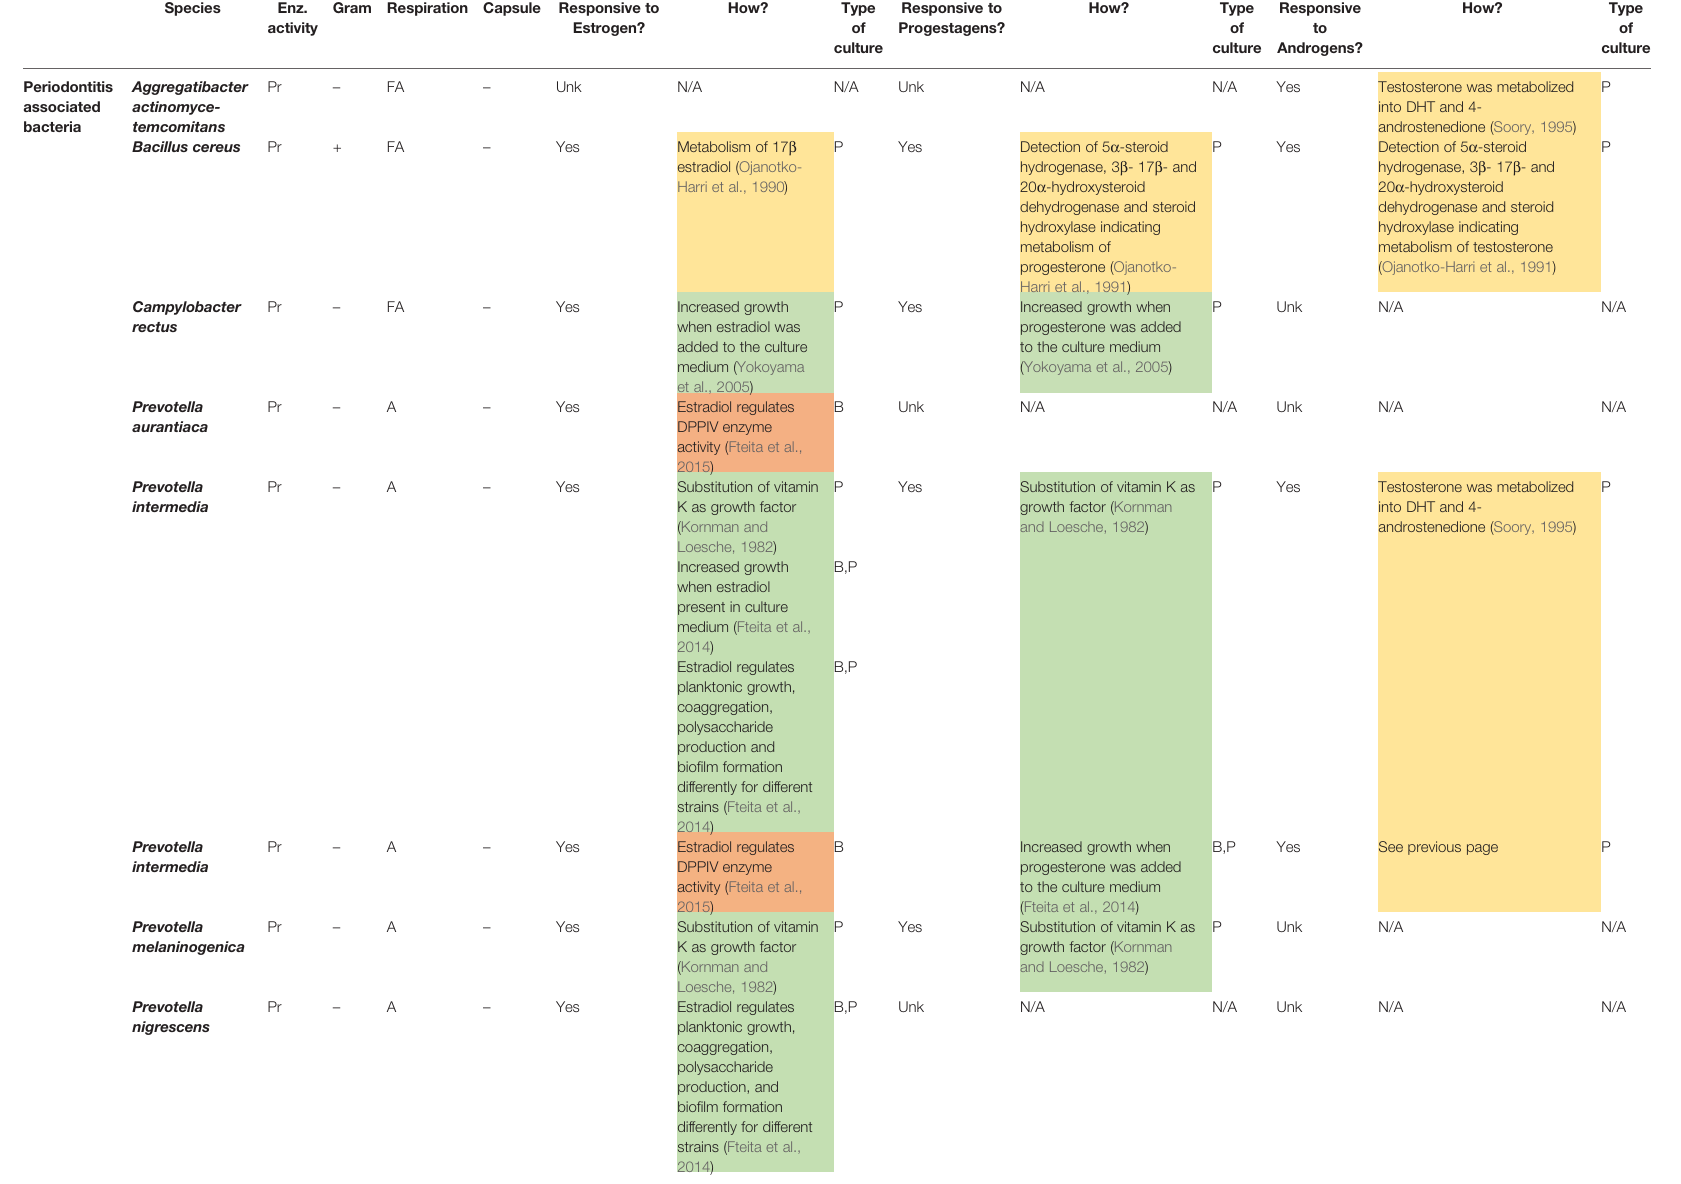
TABLE 1 | Studies that have tested the response of different oral microbes to SSH in vitro .